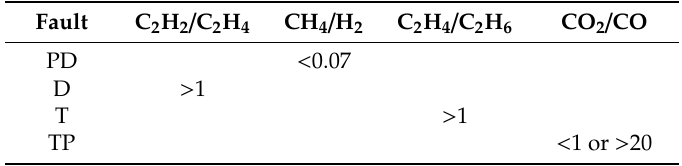
Table 4. Simplified interpretation scheme of gas ratios for bushings proposed in the IEC 60599 Standard.